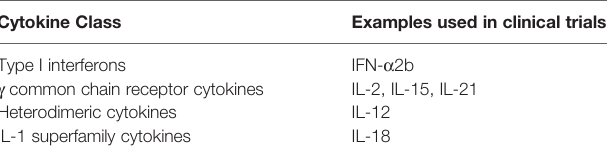
TABLE 1 | Cytokines investigated in Cancer Immunotherapy. Cytokine Class Examples used in clinical